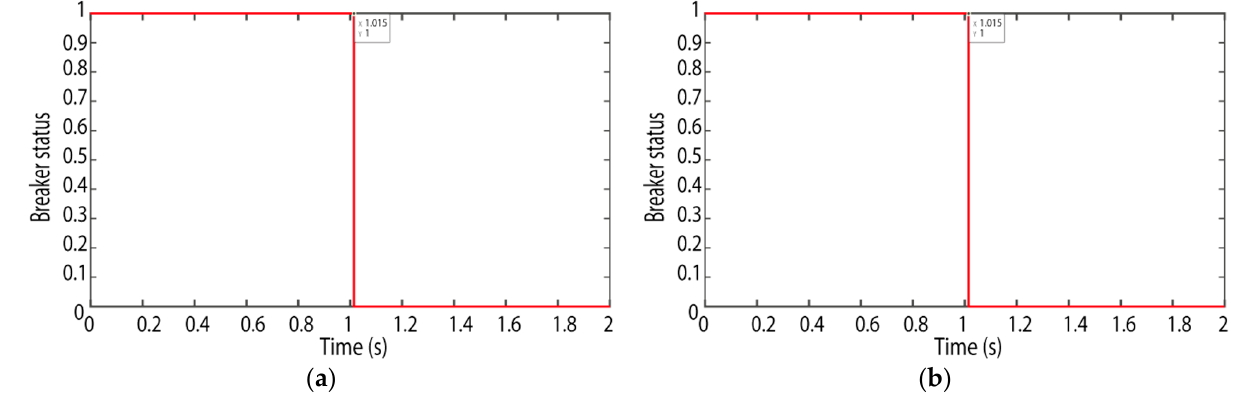
Figure 8. CB3 ( a ) and CB4 ( b ) Breaker status during cyber-attack.